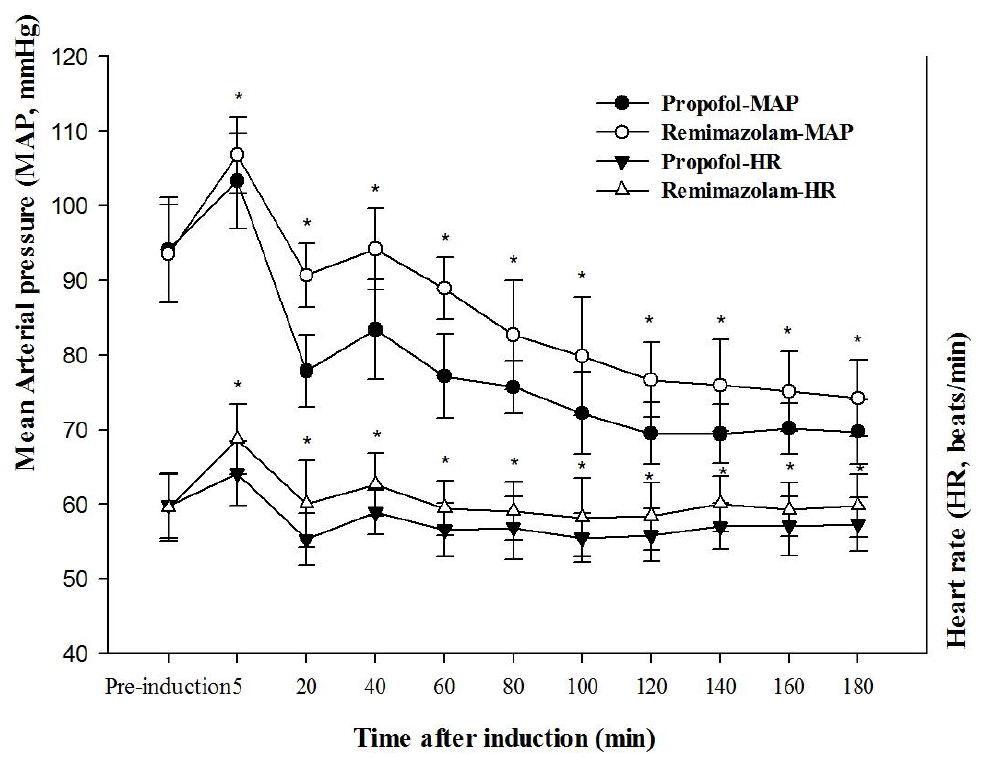
Figure 5. Mean arterial pressure and heart rate change after induction of general anesthesia with propofol or remimazolam; * p < 0.01 vs. propofol group.